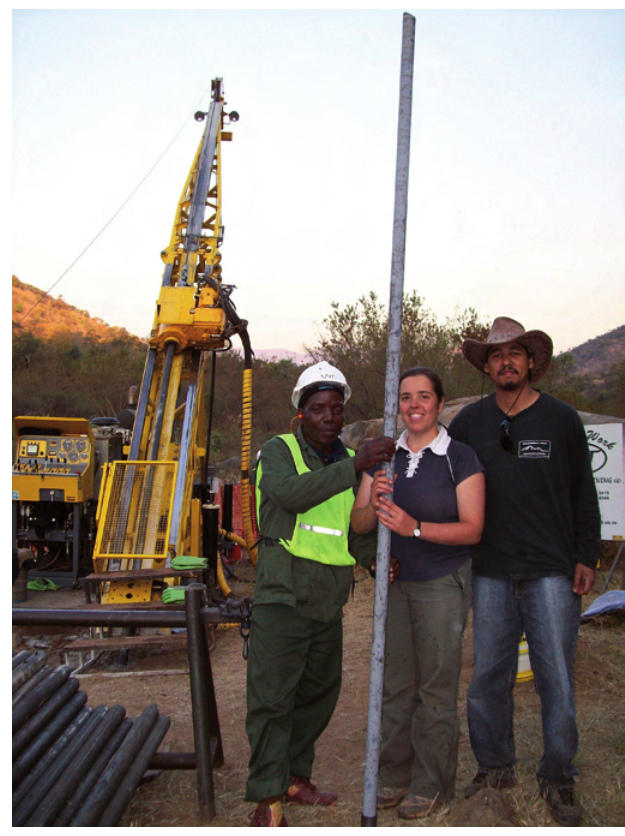
Figure 2. Drill rig aligned and set to drill at the shallowest possible angle (45°) relative to the dip and dip direction of the steep near-vertical orientation of the geological units along the Komati River. The >3-m-long rod is composed of basalt or